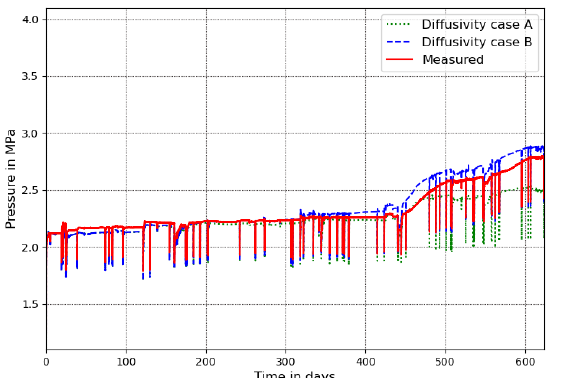
Figure 5. Predicted vs. measured rod pressure for rod 1, including the two cases for the diffusivity of doped fuel.